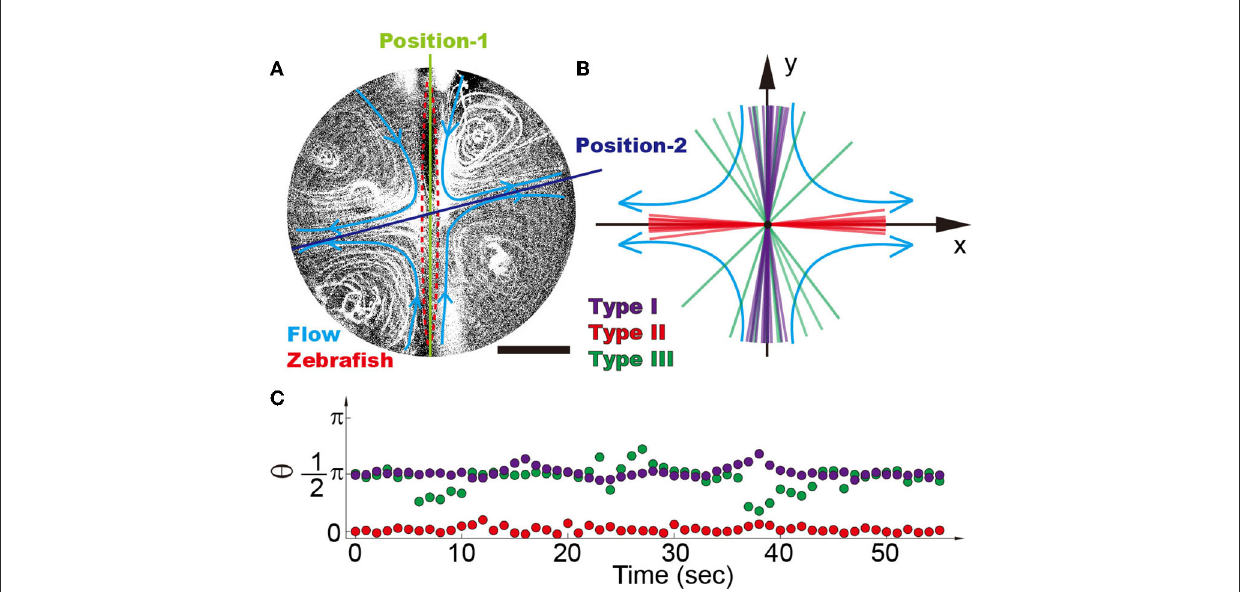
FIGURE4 (A) Four recirculating flow zones were generated surrounding the zebrafish. It is demonstrated that there are two balanced positions, i.e., position-1 denotes the inward flow and position-2 denotes the outward flow. (B) Position distribution of different types of zebrafish shows that high-mobility fishes can be easily distinguished from the low-mobility group, i.e., type I (purple), type II (red), and type III (green) zebrafish. Each line reflects the average angle of individual zebrafish over a time span of 5min. (C) Traces of single zebrafish’s movement indicate that different types of zebrafish can be distinguished from each other. Each dot represents the position angle of a zebrafish at different time points. The scale bar denotes 1mm.